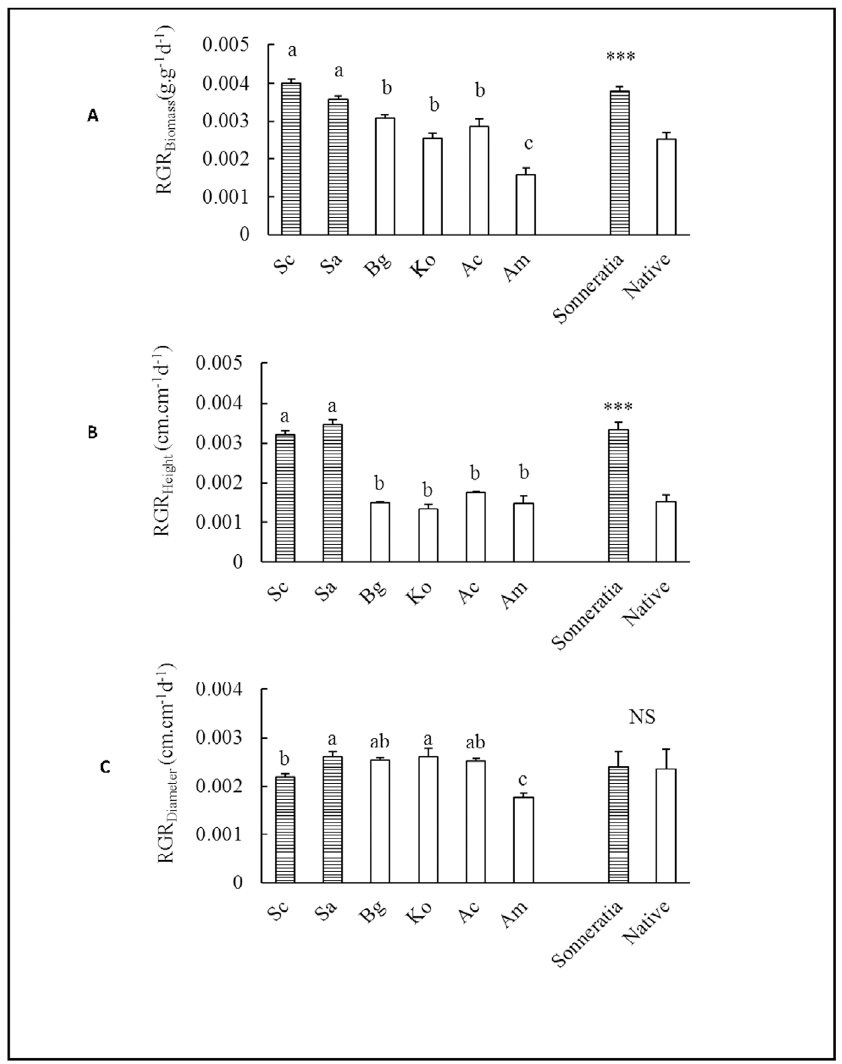
Fig 8. Comparisons of (A) RGR Biomass , (B) RGR Height and (C) RGR Diameter between alien Sonneratia and native mangrove species. Fig 8 legend: Error bars represent 1 SE. Different letters indicate significant differences at p (cid:6) 0.05 among the six species according to two-way ANOVA; *** indicates a significant difference between alien Sonneratia and native mangrove species at p (cid:6) 0.001, and NS indicates no significant difference at p (cid:6) 0.05 according to the independent samples